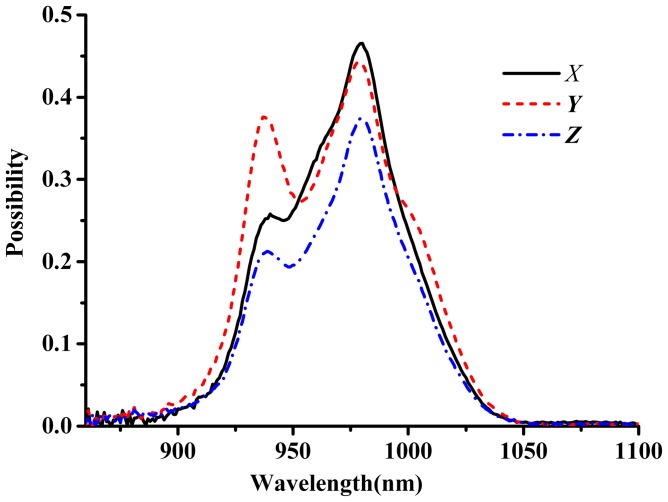
Re-absorption possibility for the three orientation of Yb3+:KBaGd(MoO4)3 crystal when Ng = 1.494×1020 cm−3, lX = lZ = 0.344 cm and lY = 0.232 cm.